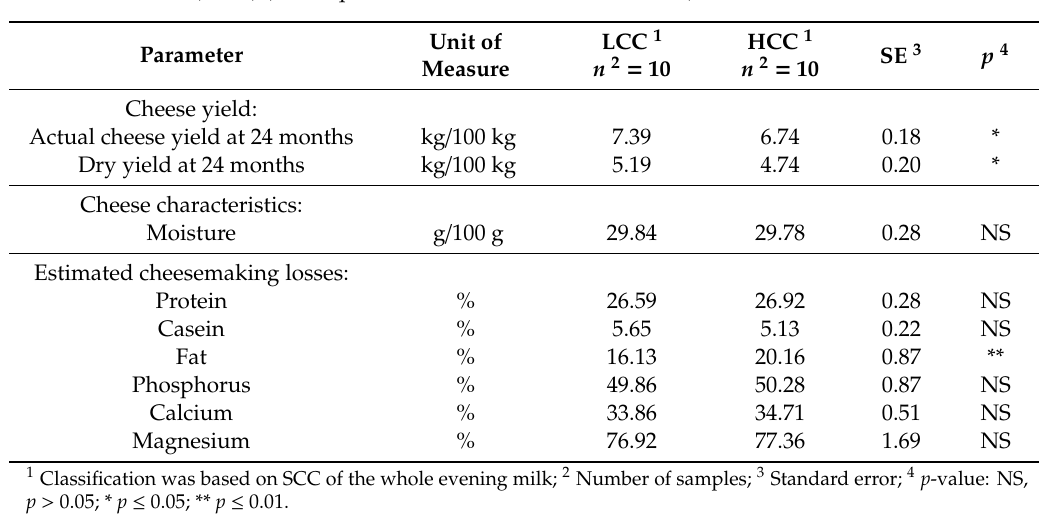
Table 2. Cheese yield and cheesemaking losses of vat milk with less than 400,000 (LCC) and more than 400,000 cells / mL (HCC) (least square mean values ± standard error).